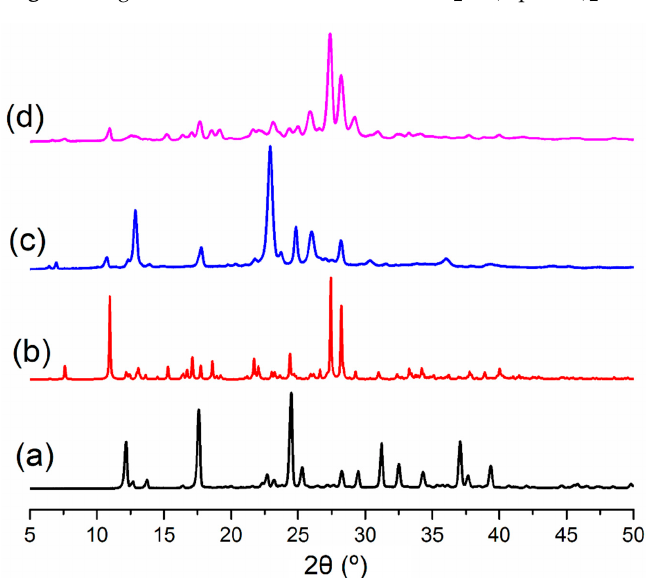
Figure 6. Tg, in black, and DSC, in blue, of H 2 Mf(HpOXA) 2 · 4W.